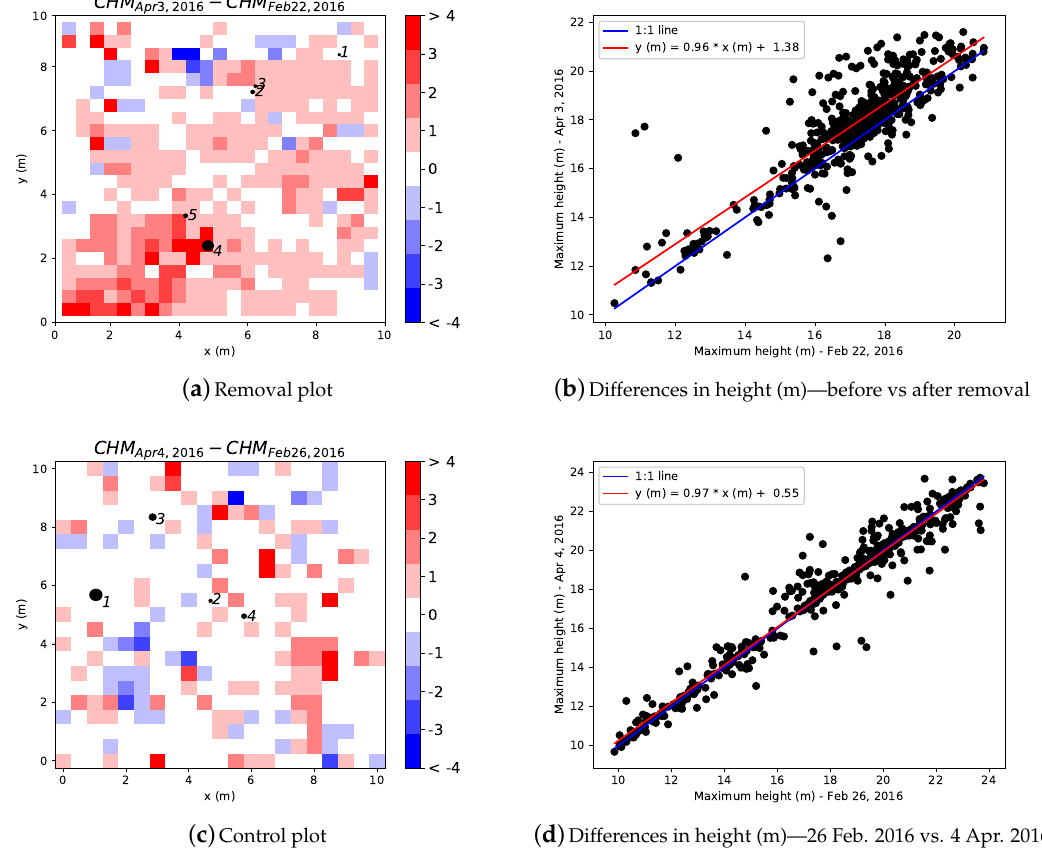
Figure 11. Difference map of the Canopy Height Models (CHM) with circles representing the location of trees ≥ 10 cm in DBH. ( a ) removal plot and ( c ) control plot. The size of the circles correspond to the size of the trees. The color scale represents the change in height in meters between the two time steps. Scatter plot showing the CHM difference between bi-temporal TLS data for removal plot ( b ) and control plot ( d